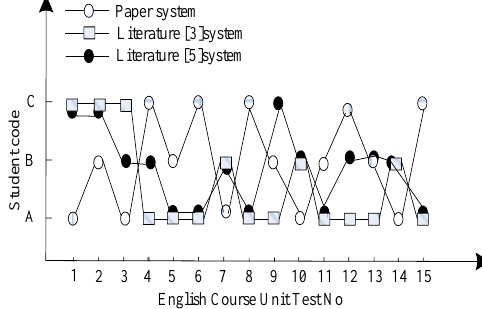
Figure 8. Recommended sequence diagram of unit